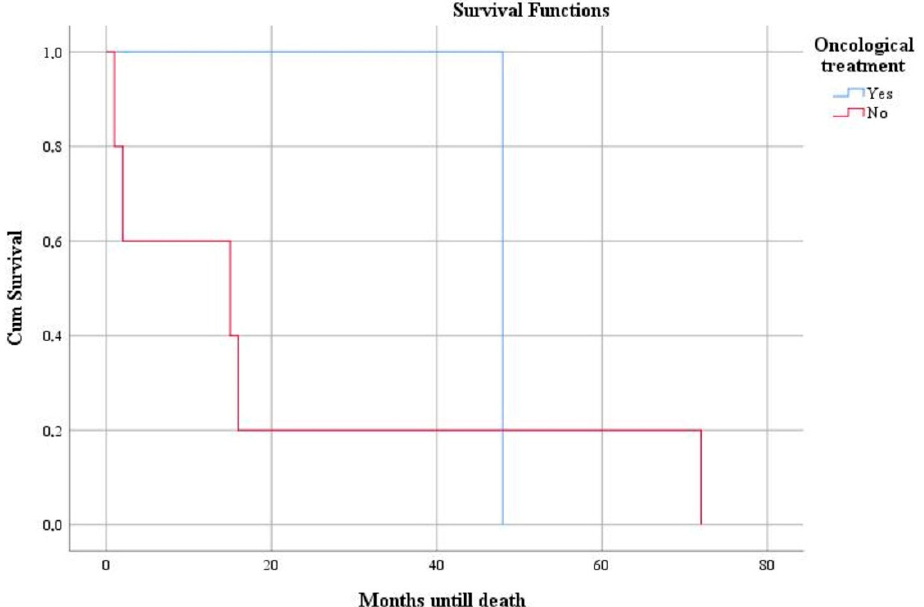
Figure 5. Kaplan–Meier survival graphic that shows a lower survival rate in case of subtotal hysterectomy.